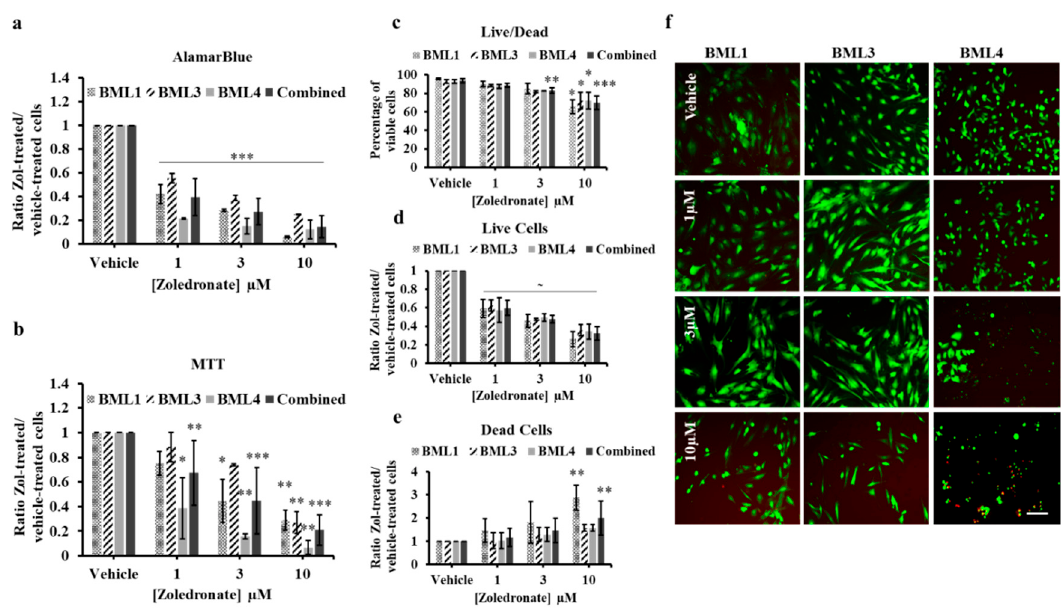
Figure 3. AlamarBlue ( a ) and MTT ( b ) assays of lung cancer-induced bone metastasis cells treated with vehicle (PBS1x) or Zol 1 µ M, 3 µ M and 10 µ M for 7 days in 1% serum conditions. The histograms in (a) and (b) represent the ratio of drug-treated cells divided by vehicle-treated cells (PBS1x) in three independent experiments. ( c ) Percentage of viable cells [number of live cells / (number of live cells + number of dead cells) × 100] and ( d ) ratio of live cells or ( e ) ratio of dead cells in vehicle or Zol-treated conditions of Live / Dead assay carried out on bone metastasis cells. ( f ) representative photos of Live / Dead assay following vehicle or Zol treatment at di ff erent concentrations. Live cells are in green and dead cells are in red. Scale bar 250 µ M. Significantly di ff erent from control * p < 0.05, ** p < 0.01, *** p < 0.001, ~ p values indicated in the results text.